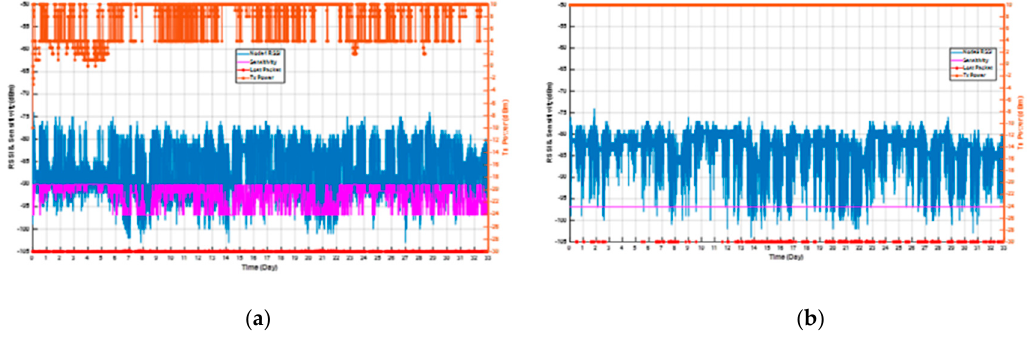
Figure 14. Experimental results of ( a ) node 4 and ( b ) node 9.